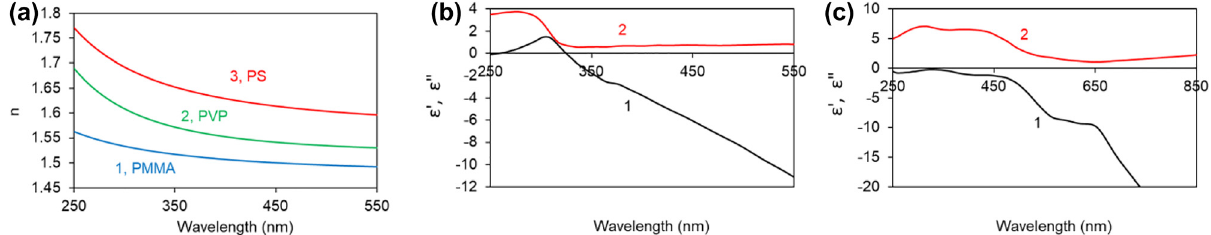
Figure 5: Refractive indexes and dielectric permittivities of polymers, Ag, and Au. (a) Spectra of refractive indexes of PMMA (1), PVP (2), and PS (3). (b and c) Spectra of real (1) and imaginary (2) parts of dielectric permittivity of Ag (b) and Au (c)